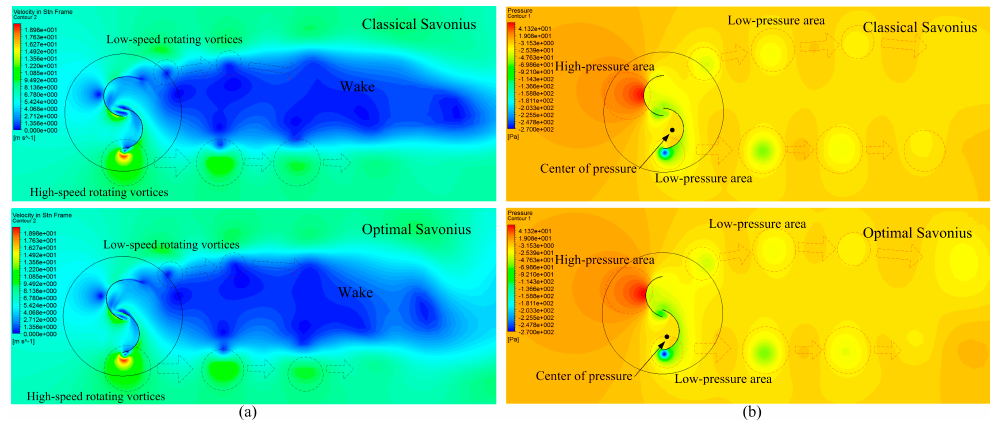
Figure 16. ( a ) Velocity distribution and ( b ) pressure distribution around the classical Savonius and optimal Savonius.